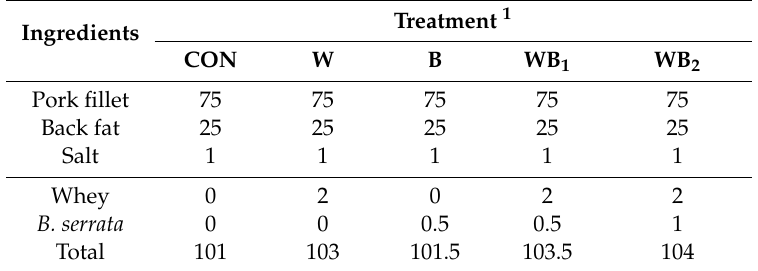
Table 1. Formulation (wt%) of pork patties containing Boswellia serrata and whey